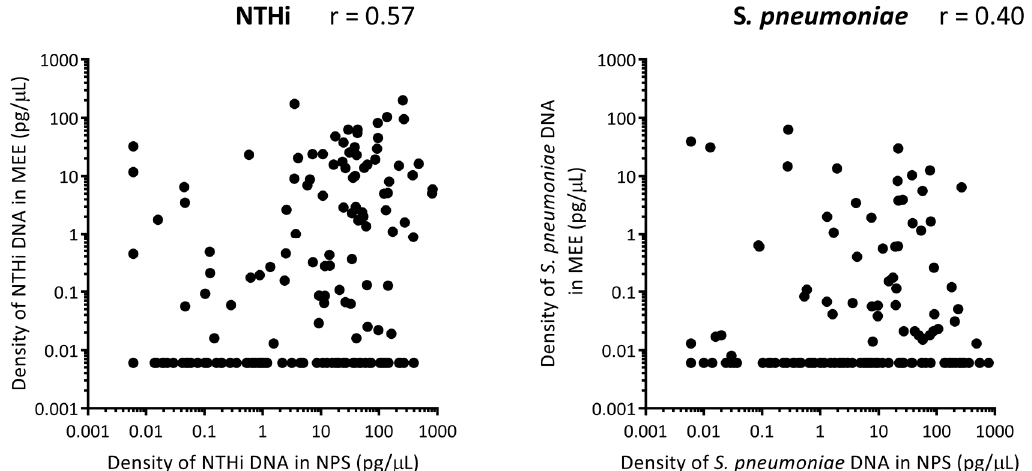
Figure 3. Correlation between otopathogen densities in the nasopharynx with otopathogen density in the middle ear of otitis-prone children. Each dot represents the density of nontypeable Haemophilus influenzae (NTHi) ( A ) and S. pneumoniae ( B ) in pg/ μ L of DNA in the nasopharynx (NPS) and middle ear effusion (MEE) of otitis-prone children. Correlation was assessed by Spearman rho, where 0.5> r >0.3 is considered a weak positive correlation and 0.7> r >0.5 is considered a moderate positive correlation.